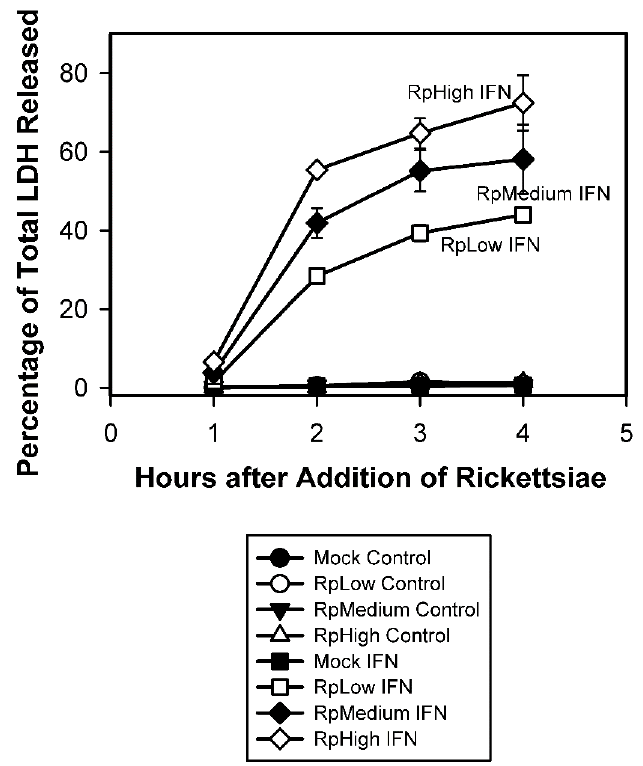
Figure 3. Release of lactate dehydrogenase (LDH) by IFN- γ -pretreated C166 endothelial cells after addition of R. prowazekii (Rp). Each value represents the mean ± standard deviation; the number of determinations for each point is shown in Table S3. Individual data points are shown in Table S4. At one hour after addition of the rickettsiae, the rickettsial infections were determined by microscopic counting of stained cells from triplicate cultures for each dilution of the rickettsial preparation used (1/900, RpLow; 1/450, RpMedium; and 1/200, RpHigh). The percentages of cells infected (means ± standard deviations) were 64.0 ± 9.5, 84.3 ± 5.9, and 94.3 ± 5.5, respectively, in the untreated cultures and 78.0 ± 4.4, 93.3 ± 3.2, and 96.0 ± 1.0, respectively, in the IFN- γ -pretreated cultures. The numbers of rickettsiae per infected cell were 3.7 ± 0.7, 6.9 ± 0.9, and 13.7 ±